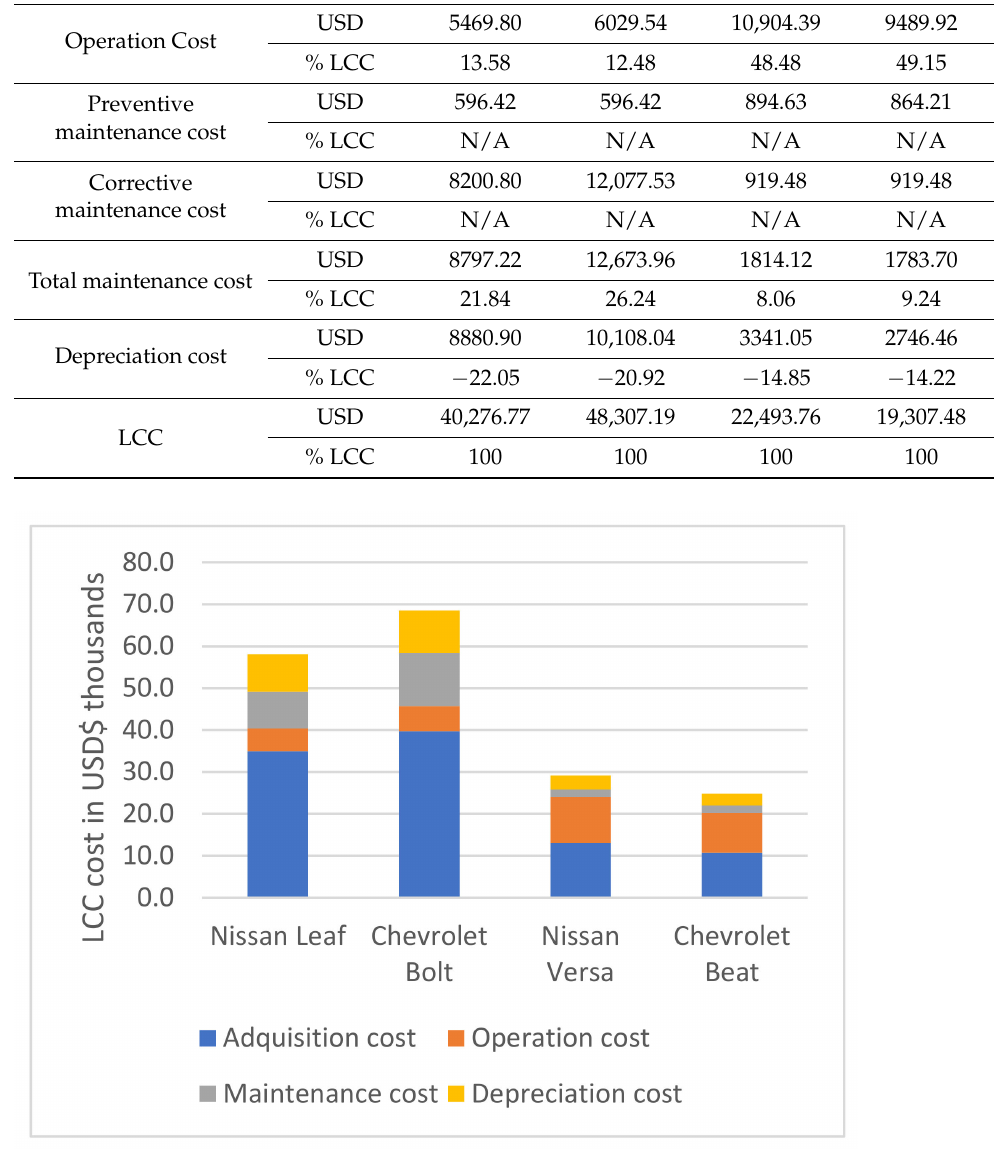
Figure 1. LCC comparison of chosen vehicles with annual distance of 15,000